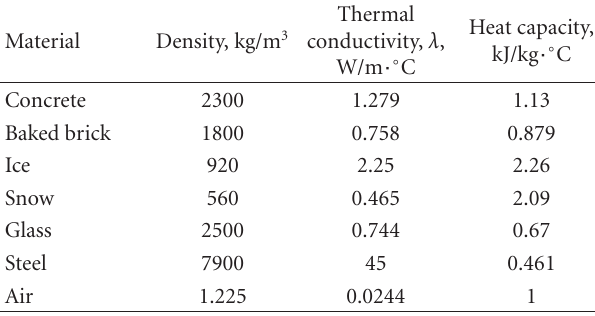
Table 1: (See [16], page 331.) Heat transfer.